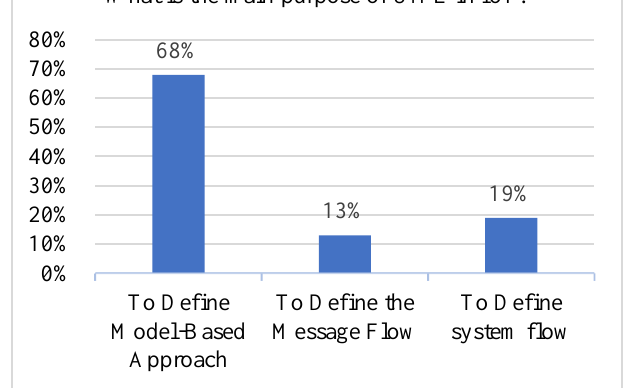
Fig. 9. Mashup tool is domain specific